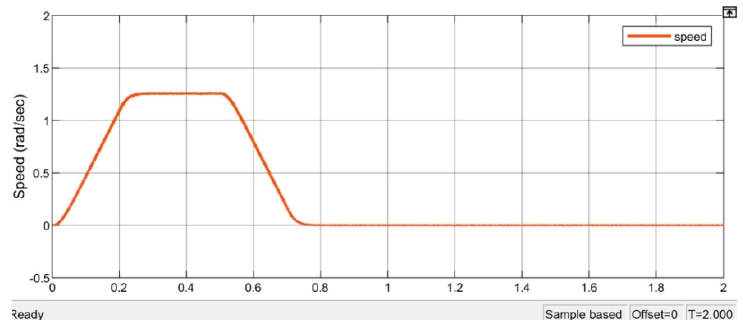
Figure 12. The speed response with load.